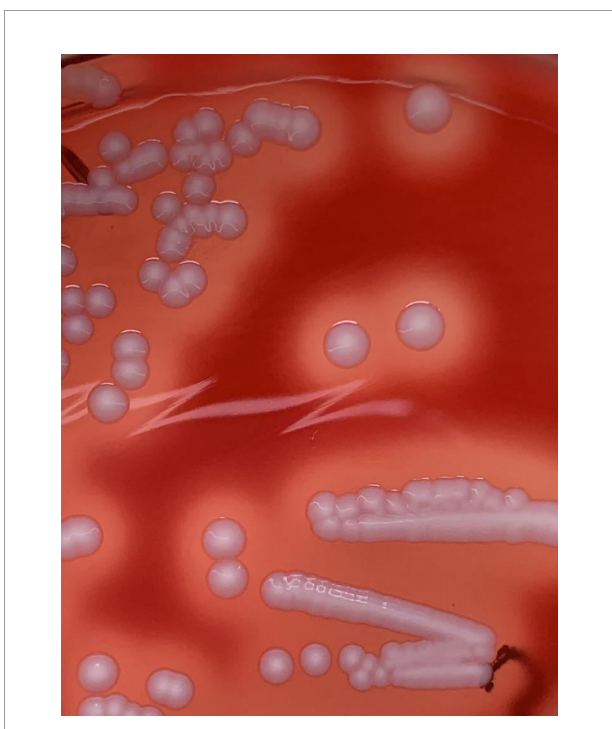
FIGURE 1 | S. argenteus (1801221) on Columbia Blood Agar (37°C, 48